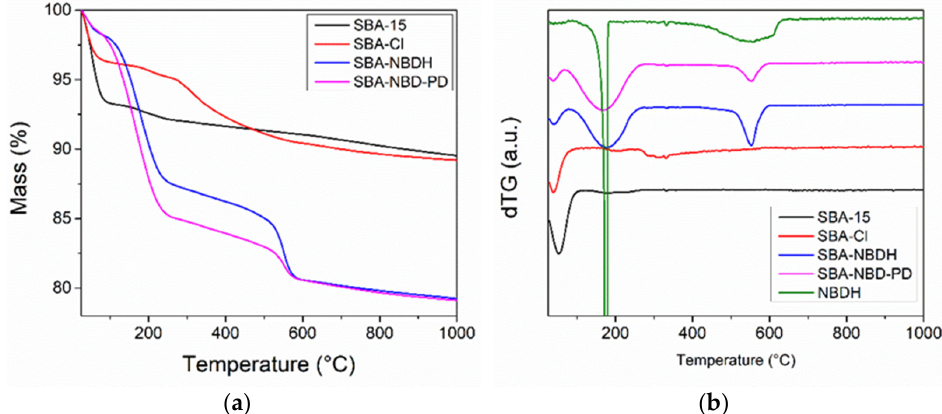
Figure 7. Thermogravimetric analyses ( a ) and differential thermogravimetric analyses (dTG) ( b ) of the pristine and functionalized SBA-15 matrices.